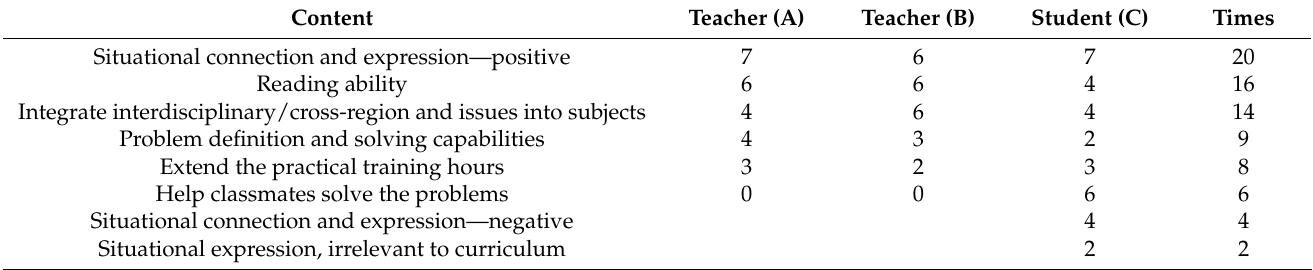
Table 21. Statistical table of a collection of organized, qualitative data including positive